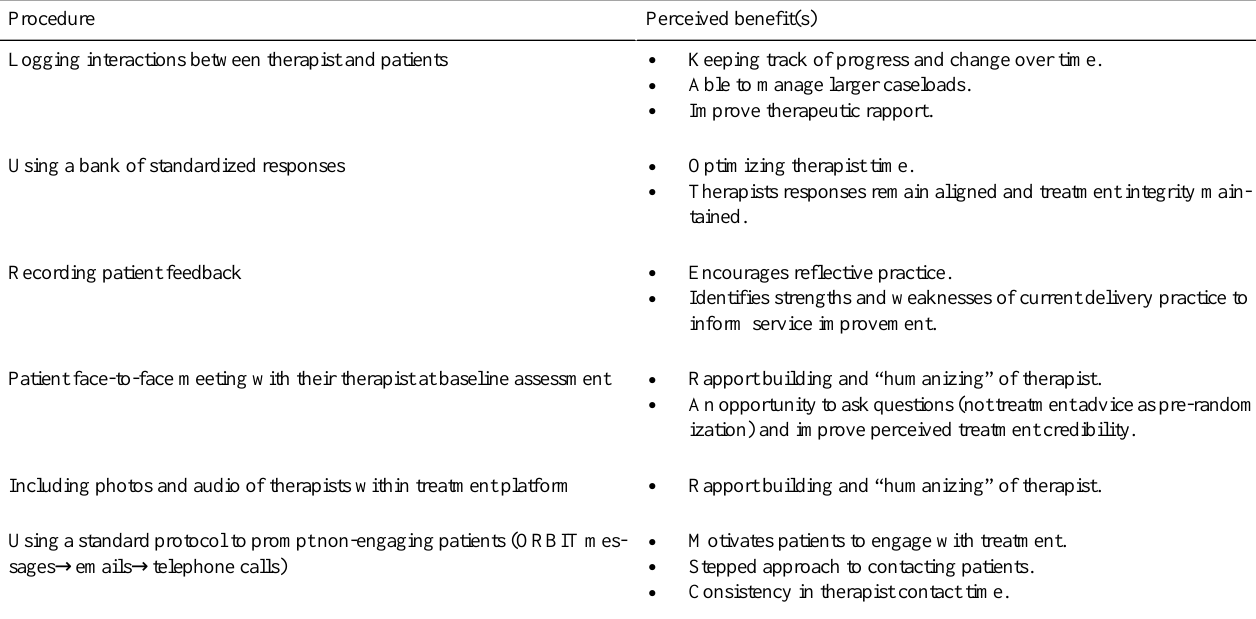
Table 2. Standard therapist procedures used in the ORBIT a trial.